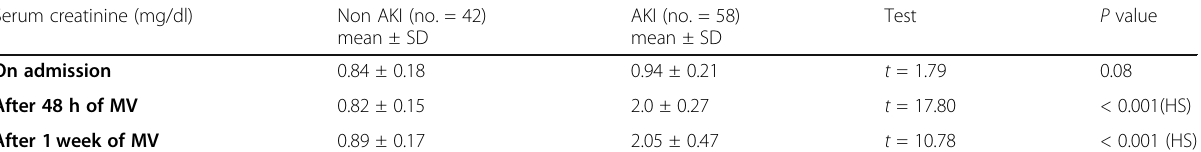
Table 2 Comparison of serum creatinine level in the studied groups on admission, after 2 days and after 1 week of starting mechanical ventilation